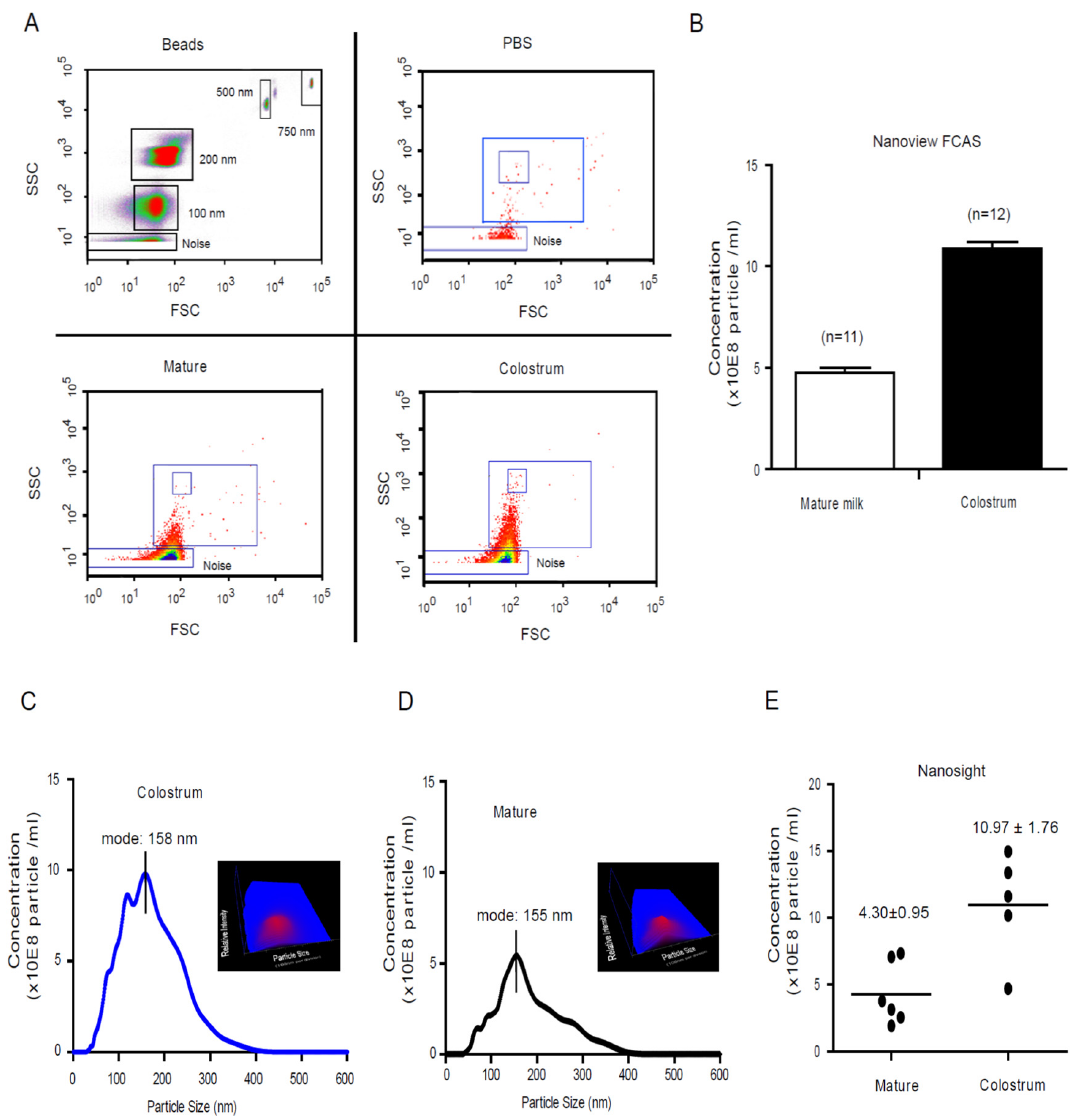
Figure 1. The dynamic profile of human milk Exosome. ( A ) NanoView identified the milk exosome size distribution area with standard beads. With need for the separation of a mixture containing 200 and 500 nm latex beads, the NanoView is capable of separating a mixture of 100–500 nm beads into distinct populations. The gating strategy for these experiments to determine instrument and background noise are described in the methods section. ( B ) The dynamic profile of vesicle size and concentration of human colostrum and mature milk were determined by NanoSight ® LM10. Size mode: 100 nanometers (nm; 3 technical replicates). The results represent the exosomes concentration by NanoSight ® analysis showing the number of exosomes per 1 mL of milk derived from different batch healthy donors’ colostrum ( C ) ( n = 6) and mature milk ( D ) ( n = 5). ( E ) The comparison of microparticle concentration of colostrum and mature milk.